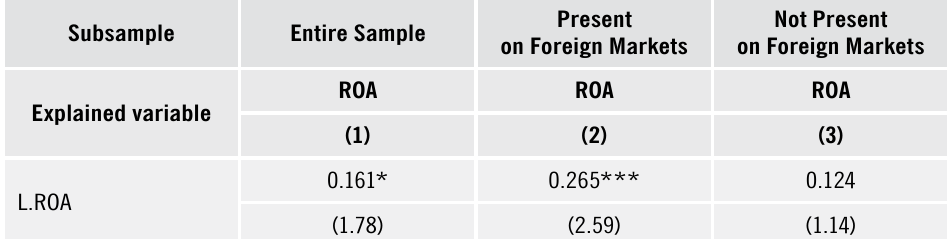
Table 10. Dynamic panel analysis of empirical relationship between international